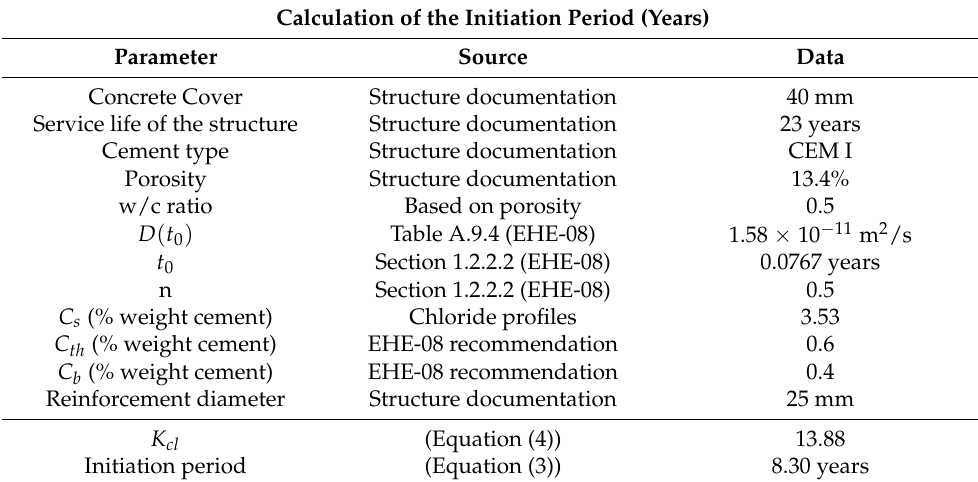
Table 3. Calculation of the corrosion initiation period. Example: Pier 9, Viaduct 3.